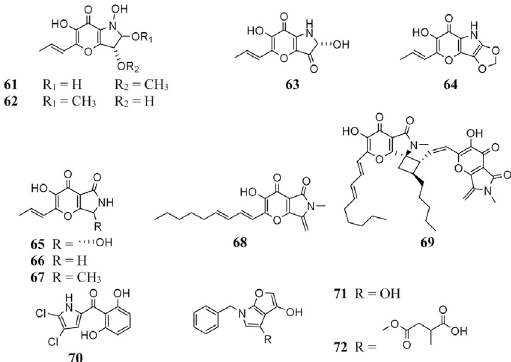
Frontiers in Chemistry |